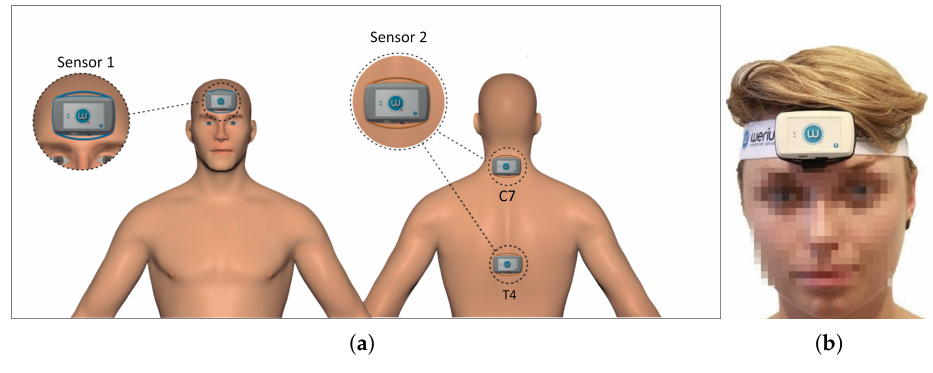
Figure 6. ( a ) Placement diagram; ( b ) Actual